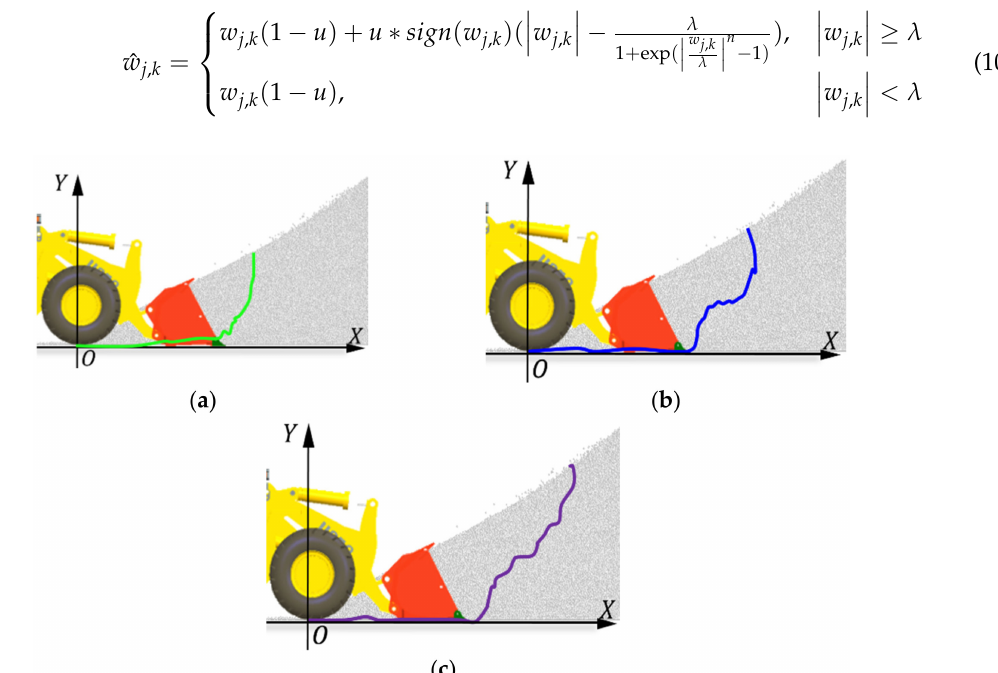
Figure 8. Three modes of shovel excavation: ( a ) one-time lifting from the bottom, ( b ) segmentary excavation, ( c ) empirical